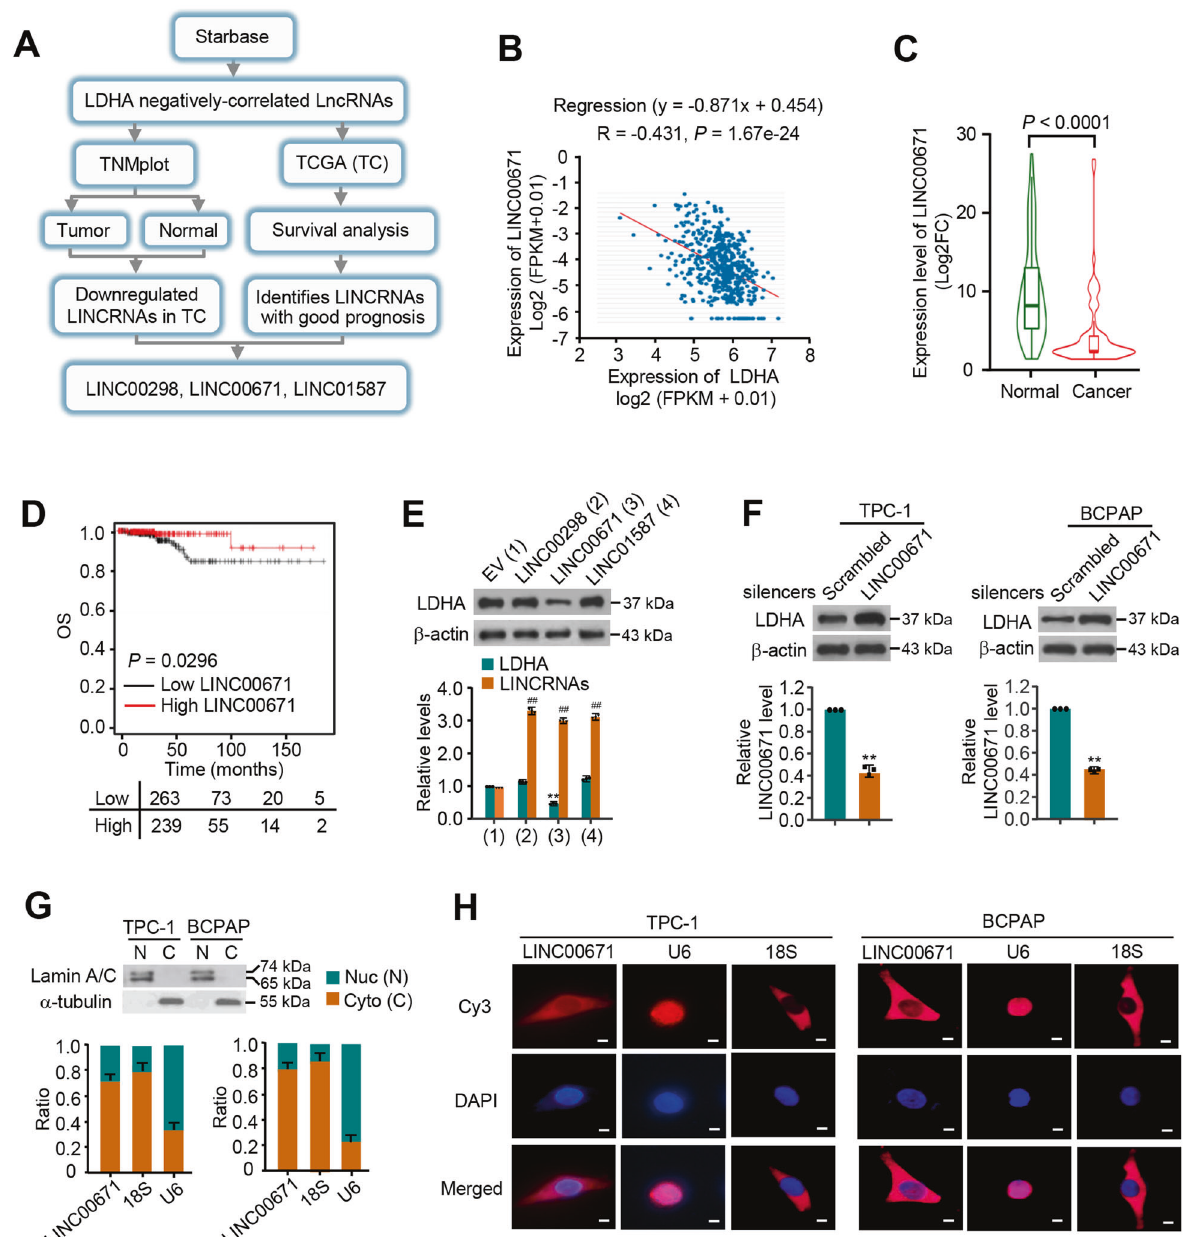
Fig. 1 LINC00671 is a novel LDHA negatively-regulated LncRNA and correlated with good clinical prognosis. A Schematic of the screening strategy to identify lncRNAs that are downregulated in TC and negatively correlated with LDHA. B Pearson correlation analysis of the expression of LINC00671 and LDHA in TC tissue (http://starbase.sysu.edu.cn). C The expression of LINC00671 in TC patients and normal controls demonstrated by TNM plot under the item of compare tumor and normal section (https://www.tnmplot.com/). D Kaplan – Meier analysis of the overall survival rate (log-rank test, two sides) of TC patients with low ( n = 361) or high ( n = 310) expression of LINC00671 (http://kmplot.com/analysis/). E The protein levels and mRNA levels of LDHA in TPC-1 cells transfected with empty vector, LINC00298, LINC00671, and LINC01587 expression vectors. Orange bars show the levels of transfected LncRNAs including LINC00671. F The expression levels of LDHA and LINC00671 in TPC-1 cells (left panel) and BCPAP (right panel) transfected with scrambled and LINC00671 smart pool of silencers. The data are expressed as mean ± standard error. G The expression of LINC00671 in TPC-1 and BCPAP cells was detected by qRT-PCR. The separation of the nucleus and cytoplasm was estimated by western blot. Lamin A/C is used as a nuclear marker and tubulin is used as a cytoplasmic marker. H Subcellular localization of LINC00671 (red) in TPC-1 and BCPAP cells by combining RNA FISH and immuno fl uorescence. The nucleus was stained with DAPI (blue). Scale bar = 10 μ m. All values shown are mean ± SD of triplicate measurements and have been repeated three times with similar results (** P < 0.01 versus corresponding control LDHA. ## P < 0.01 versus corresponding control of lncRNAs). Cytosolic and nuclear fractionation with 10 mM DTT at 37 °C for 30 min and in ChIP buffer (150 mM NaCl, The localization of the protein is determined by subcellular classi fi cation. 1% Triton X-100, 2 mM EDTA, 20 mM Tris-HCl, pH 8.1). A promoter pair Brie fl y, TPC-1 and BCPAP cells were washed with PBS twice and of speci fi c primer for the LINC00671 promoter was used to amplify the incubated with lysis buffer (25 mM Tris-HCl, pH 7.4, 1 mM MgCl 2 , immunoprecipitated DNA. The value was normalized to the value of 5 mM KCl, and 1% NP-40) on ice for 10 min. Cells were homogenized IgG or empty vector control. Cell Death and Disease (2021)